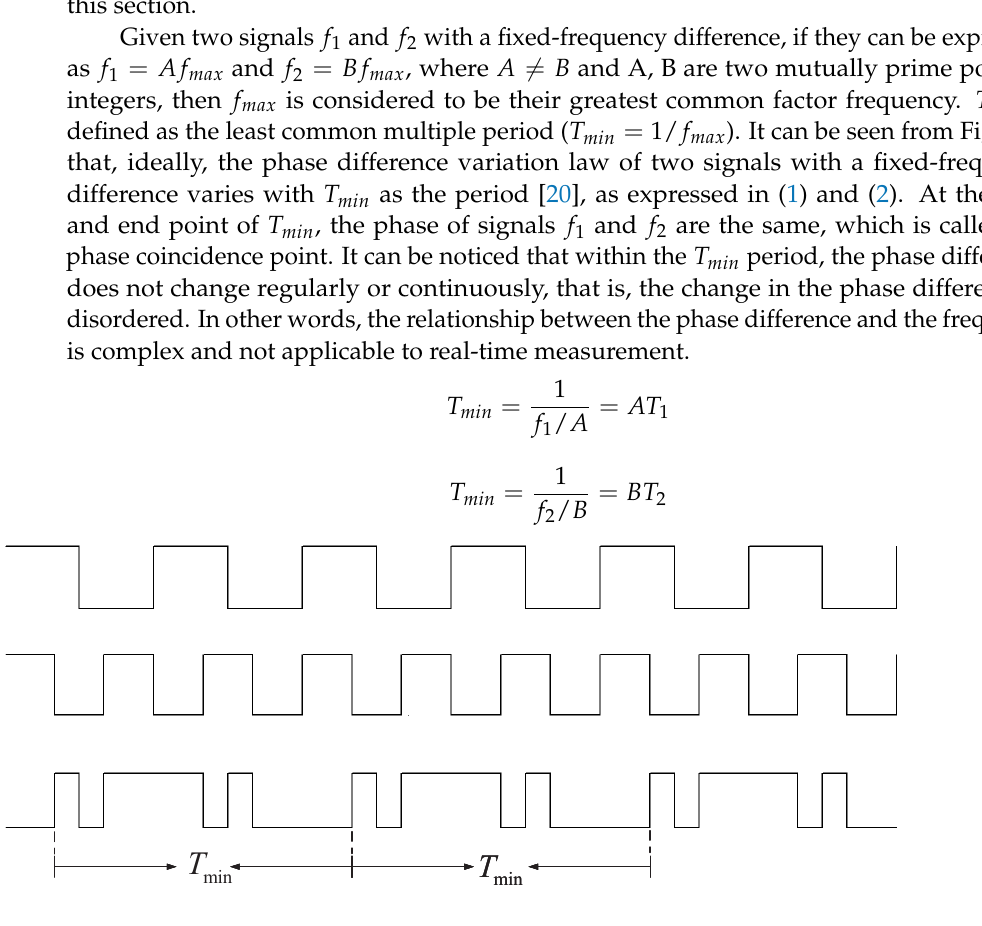
Figure 2. Variation of phase difference between two signals with a fixed-frequency